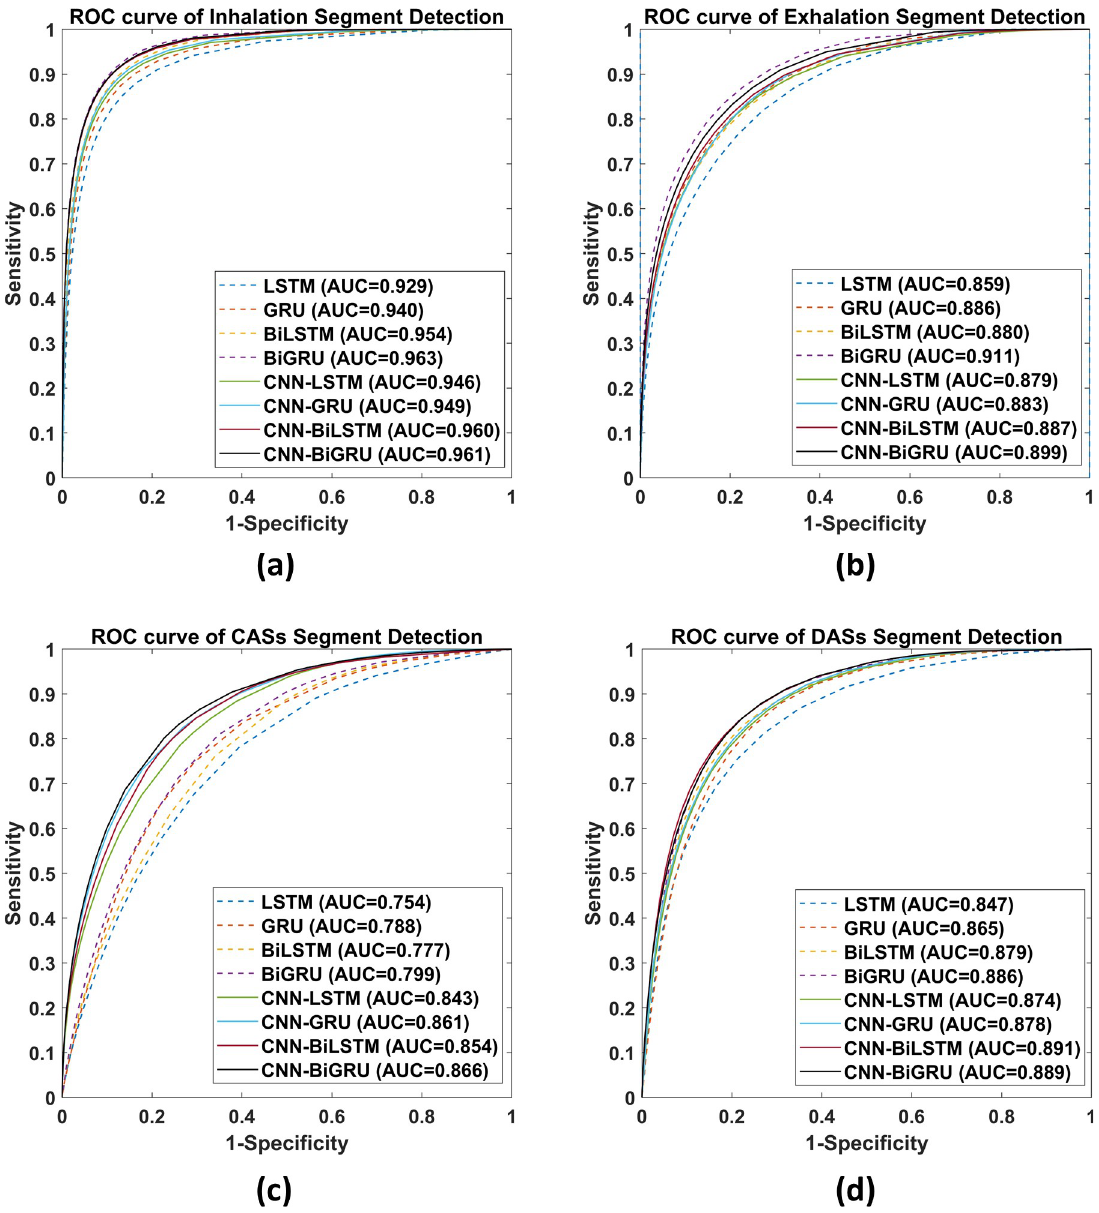
Fig 7. ROC curves for (a) inhalation, (b) exhalation, (c) CAS, and (d) DAS segment detection. The corresponding AUC values are